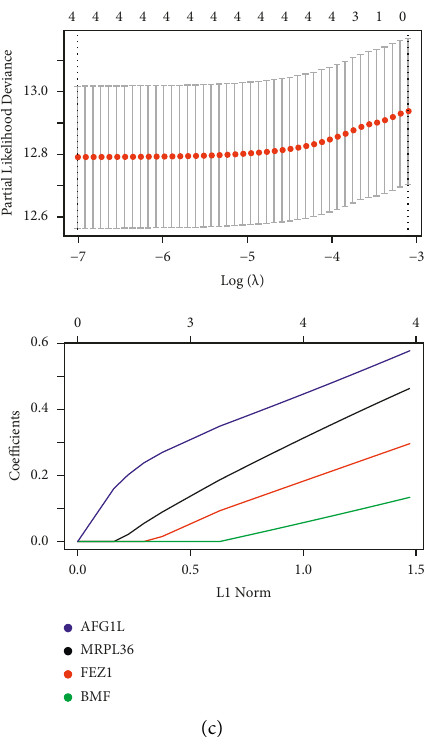
Figure 1: Screening of mitochondria-related genes and establishment of a risk score model. (a) Differential (increased or reduced) mitochondria-related gene expression in the hazard group compared with that in the normal group. (b) Error rates of randomly generated trees (upper panel). Variable relative importance of the four selected mitochondria-related genes. (c) LASSO analysis: partial likelihood deviance values were plotted against log ( λ ) (upper panel). The relative abundance of the selected genes varies with the risk